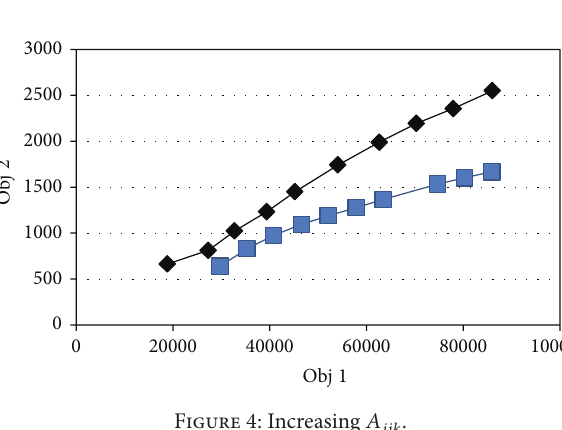
Figure 4: Increasing 𝐴 𝑖𝑗𝑘 .